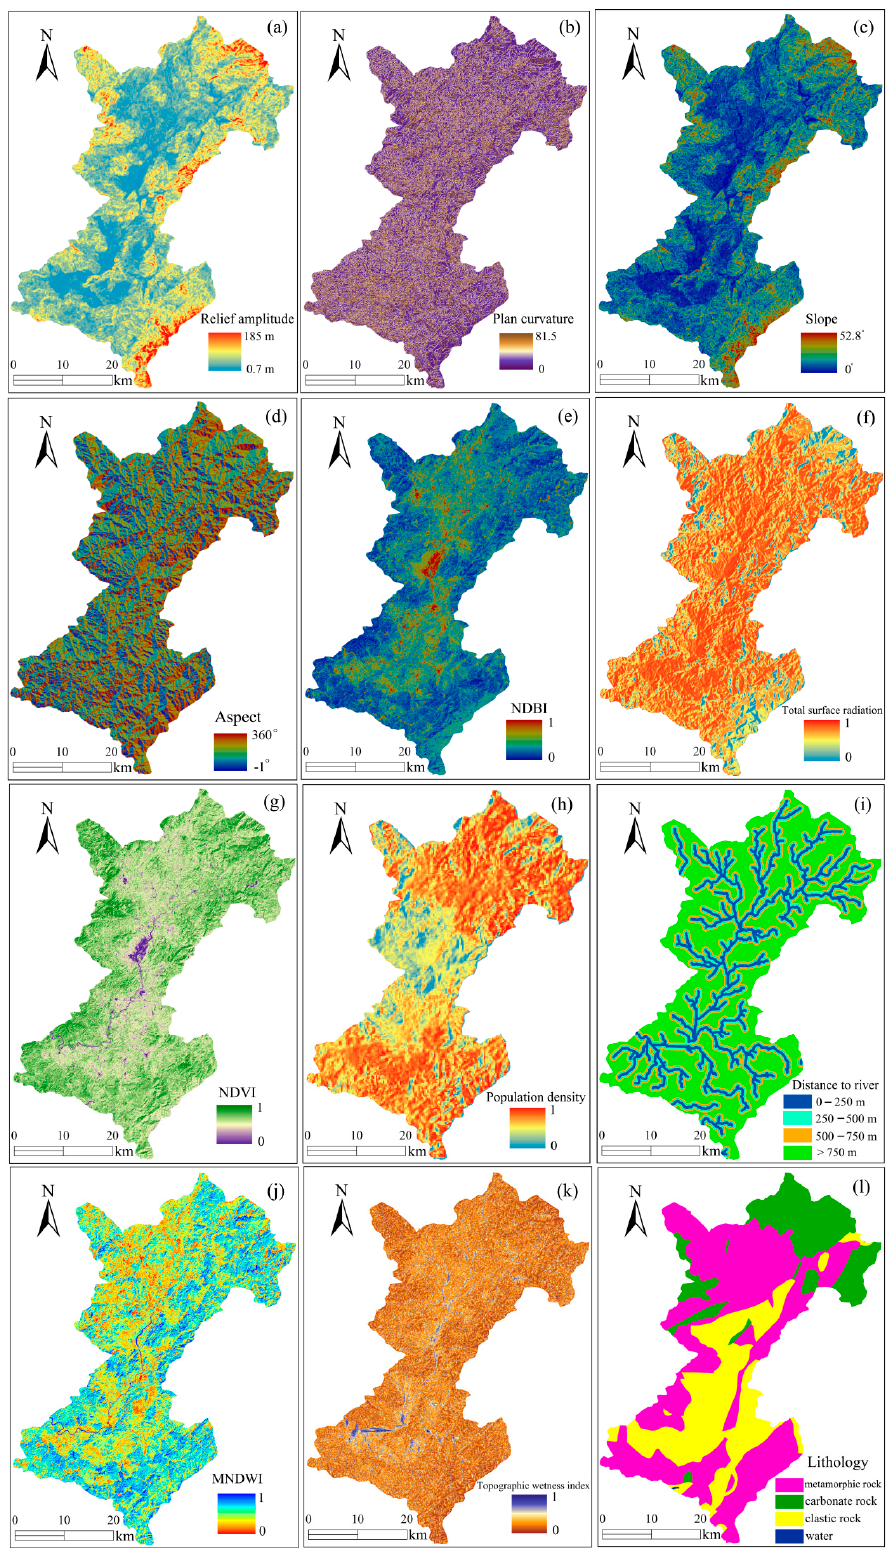
Figure 4. Landslide environmental factors (elevation and profile curvature are not presented): ( a ) Relief amplitude, ( b ) Plan curvature, ( c ) Slope, ( d ) Aspect, ( e ) NDBI, ( f ) Total surface radiation, ( g ) NDVI, ( h ) Population density, ( i ) Distance to river, ( j ) MNDWI, ( k ) Topographic wetness index, ( l ) Lithology.